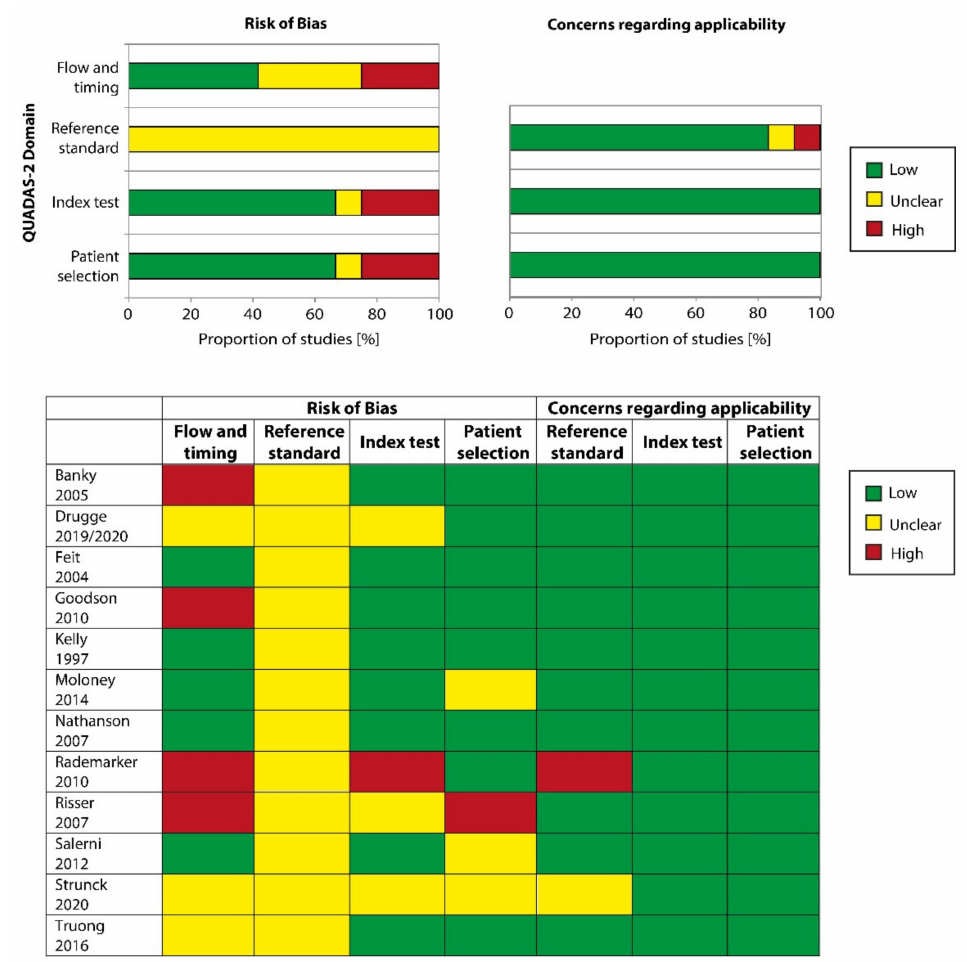
Figure 3. Risk of bias and applicability concerns graph: review authors’ judgments about each domain presented as percentages across included studies. Risk of bias and applicability concerns summary: review authors’ judgments about each domain for each included